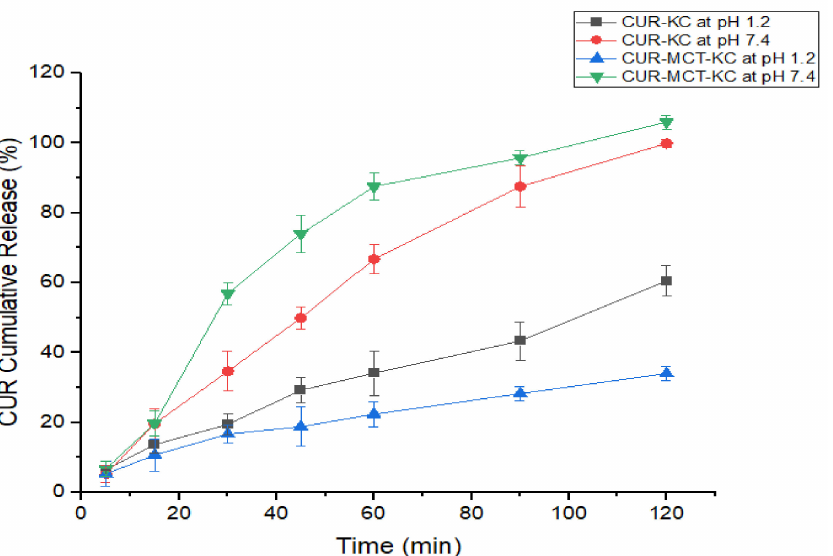
Figure 8. Cumulative release characteristics of CUR from CUR-KC and CUR-MCT-KC under the influence of different pH: acidic pH 1.2 and alkali pH 7.4. The release experiment was the performance at 37 ◦ C in a PBS buffering system, with gentle shaking at 150 rpm over 2 hr. CUR release (%) was monitored at specific intervals: 5th, 15th, 30th, 45th, 60th, 90th, 120th